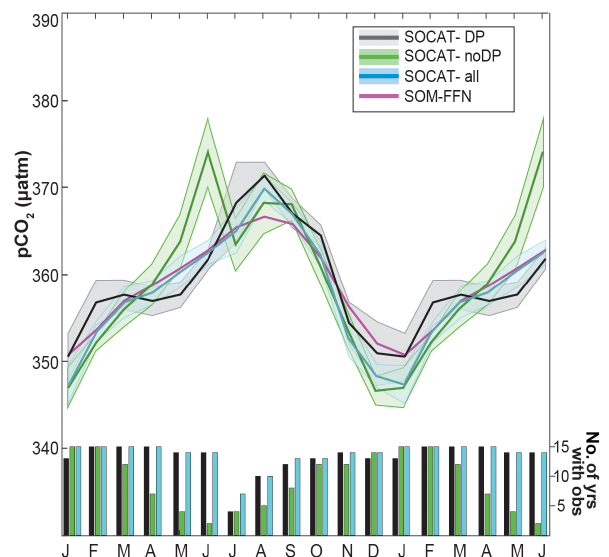
Figure 2. Mean surface ocean p CO 2 seasonal cycle estimate for years 2002–2016, for the SPSS biome from each dataset, shown on an 18-month cycle, calculated from a time series corrected to year 2002 (atmospheric trend of 1.95µatmyr − 1 removed). Shading rep- resents 1 standard error for biome-scale monthly means driven by interannual variability; there is no error represented for SOM-FFN. Bar plot indicates the number of years containing observations in a given month (maximum of 15 years) for the SOCAT-DP, SOCAT- noDP, and SOCAT-all